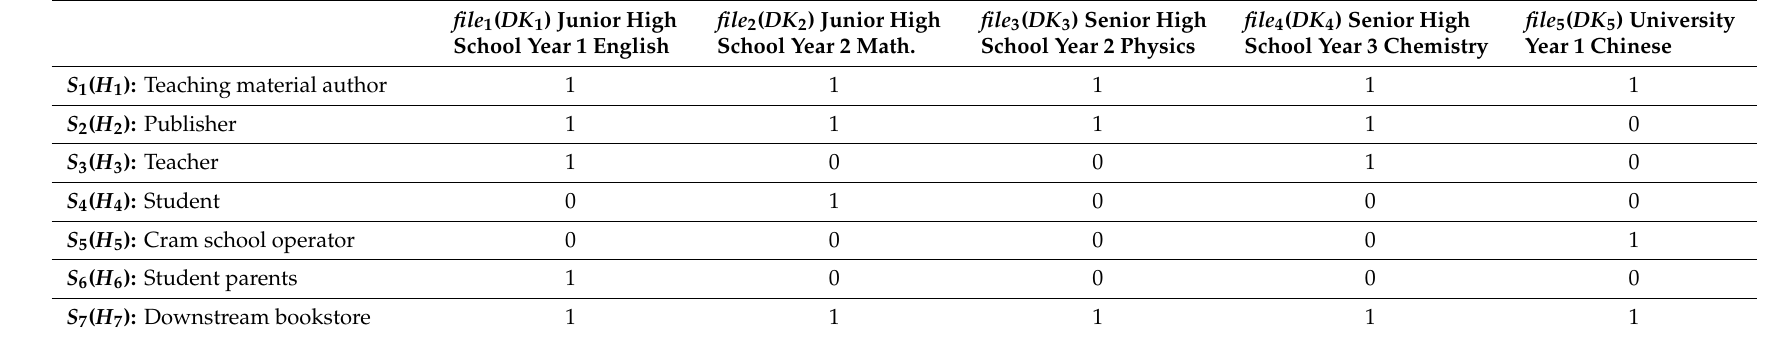
Table 6. The resulting after updating of a user